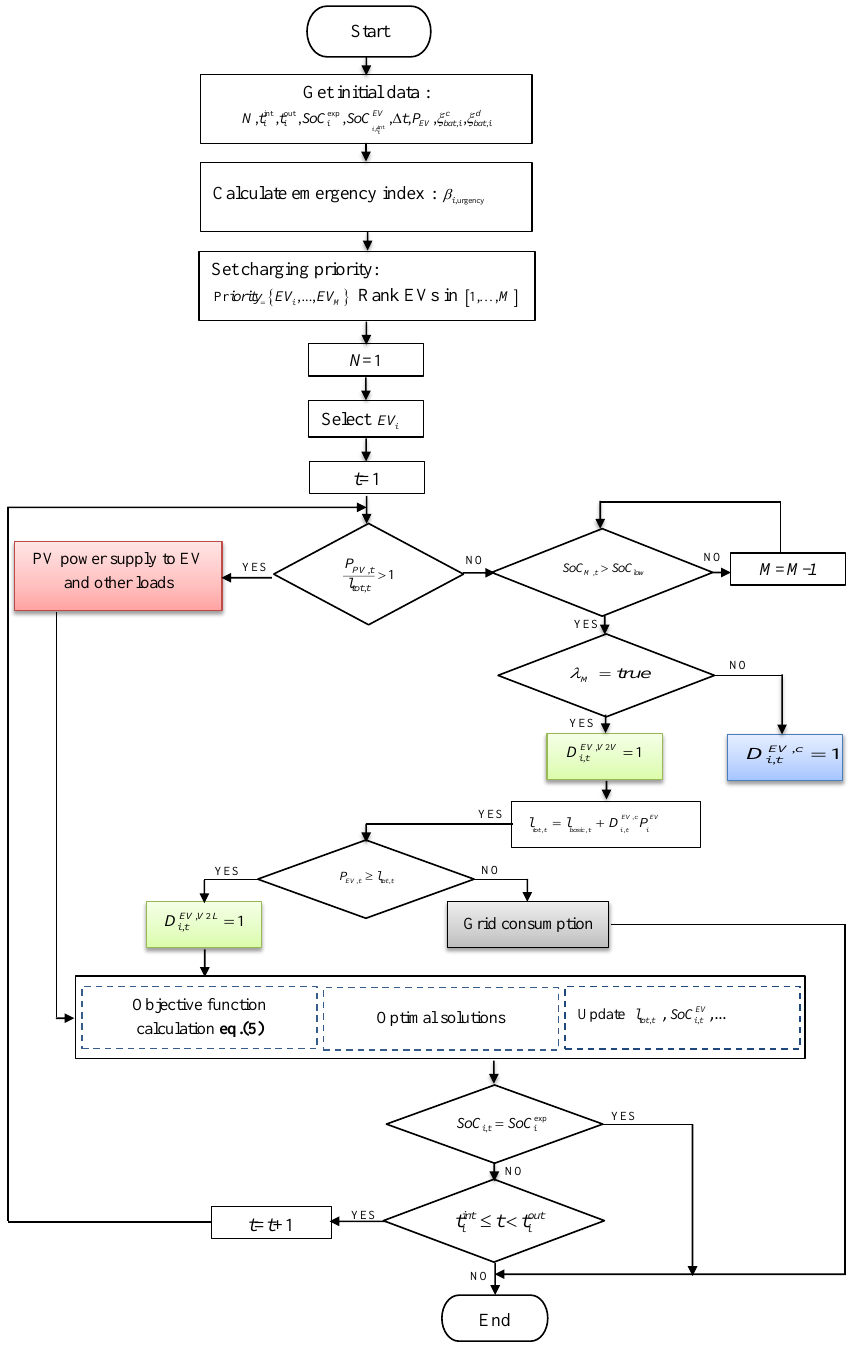
Figure 3. Flowchart of the proposed Bi-CPM scheme. Algorithm 1 displays the key workflow steps for the MIP model using the Gurobi